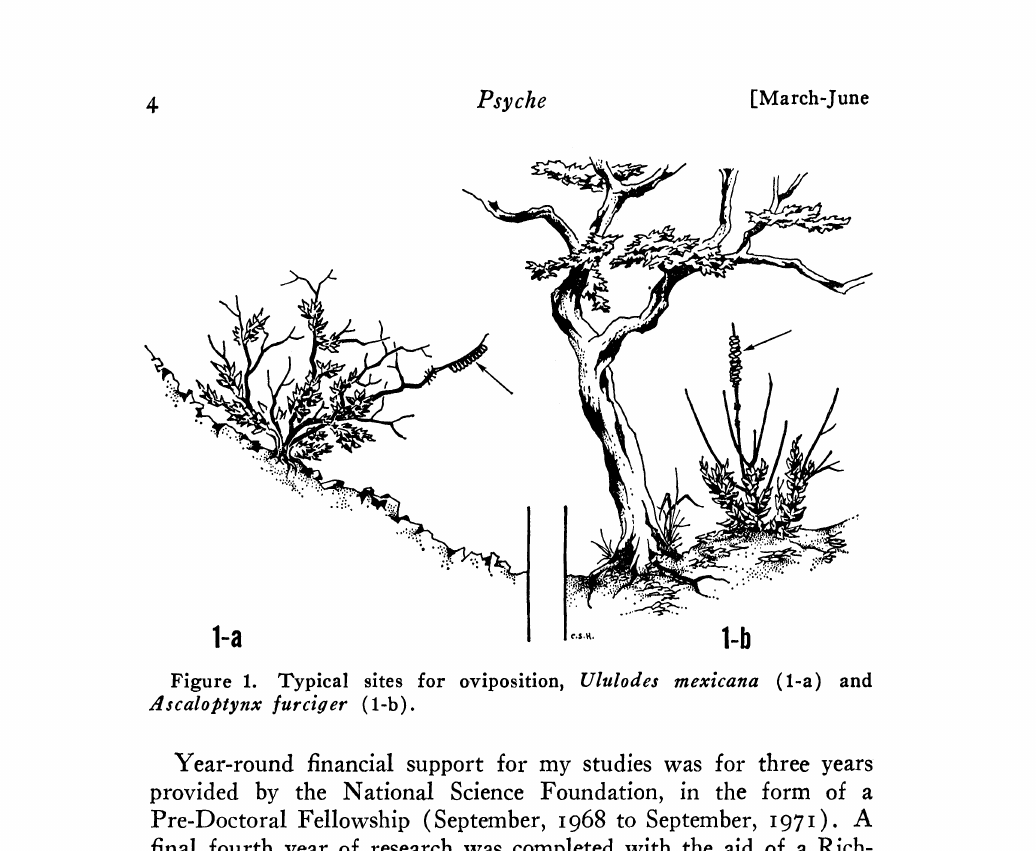
Figure 1. Typical sites for oviposition, Ululodes mexicana (l-a) and Ascaloptynx [urciger